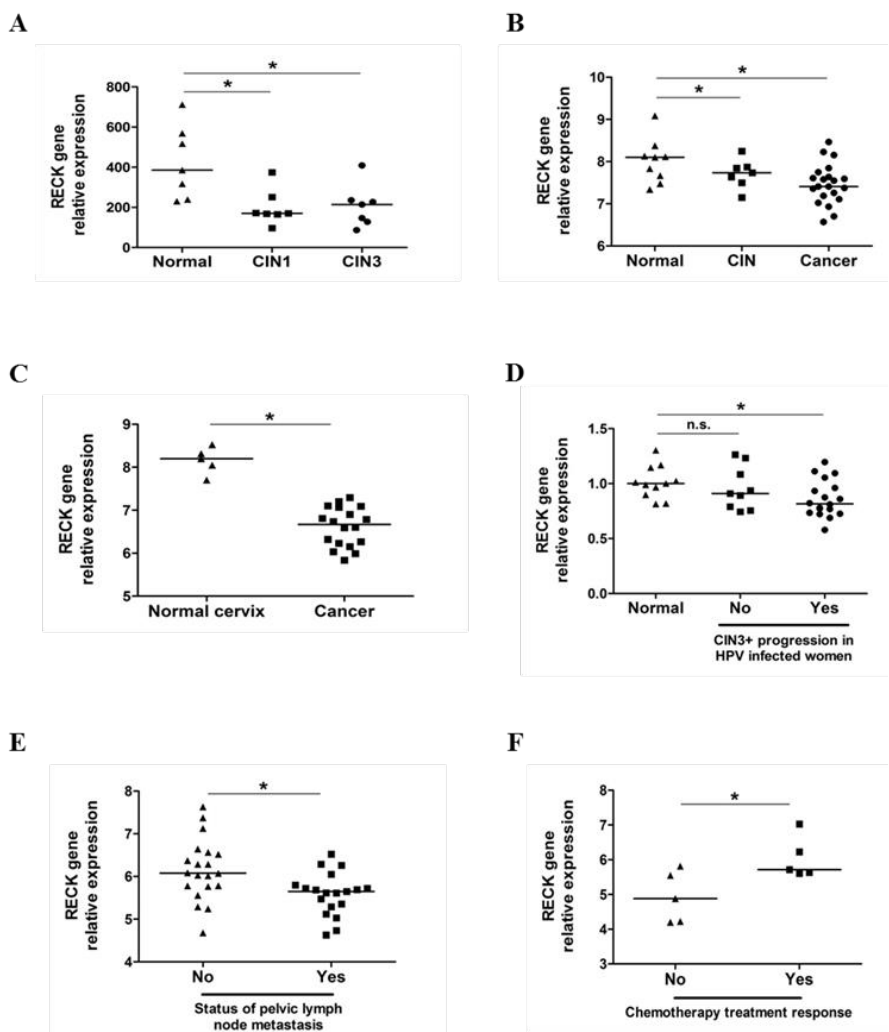
Figure 7. RECK expression is down regulated in cervical intraepithelial neoplasias (CIN) and invasive carcinomas being associated with worse clinical outcome of cervical cancer patients. ( A ). RECK gene expression is down regulated in CIN1 and CIN3 when compared with normal cervical tissues (GSE51993). ( B , C ). RECK gene expression is decreased in CIN and invasive carcinomas, when compared to normal cervical tissues (GSE7803 and GSE39001). ( D ). RECK relative expression is down regulated in women with HPV positive CIN that progressed to CIN3 or worse, when compared to women with no HPV infection (GSE75132). ( E ) RECK expression is down regulated in early-stage cervical carcinoma patients who presented pelvic lymph node metastasis, when compared to the same stage cervical carcinoma patients without metastasis (GSE26511). ( F ). RECK expression is up regulated in cervical cancer patients who presented better response to chemotherapy when compared to patients with no treatment response (GSE70035). * p < 0.05 by Kruskal – Wallis (7A, 7B and 7D) or Mann – Whitney (7C, 7E and 7F) test.